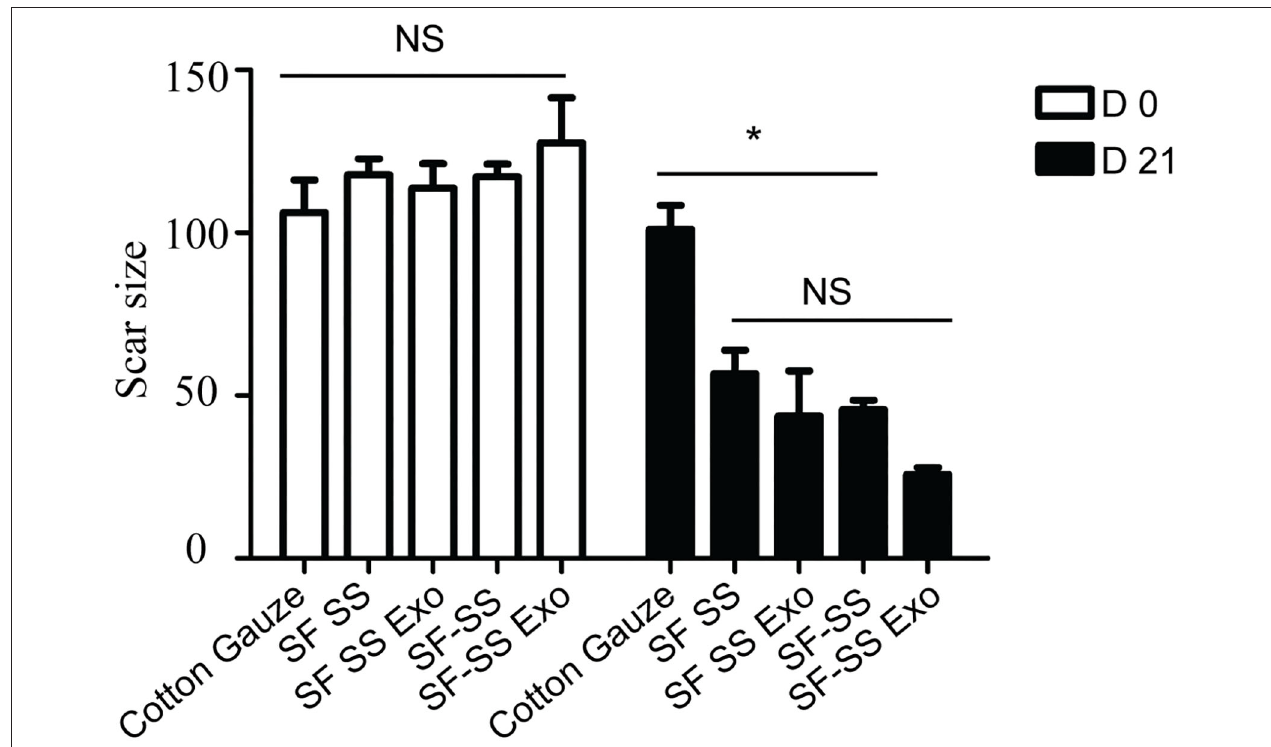
FIGURE 4 | The wound closure ability of SF SS and SF-SS hydrogel. The scar size analysis by Image J. Data is shown as mean ± standard deviation ( n = 3). ns, no significant difference, * p <